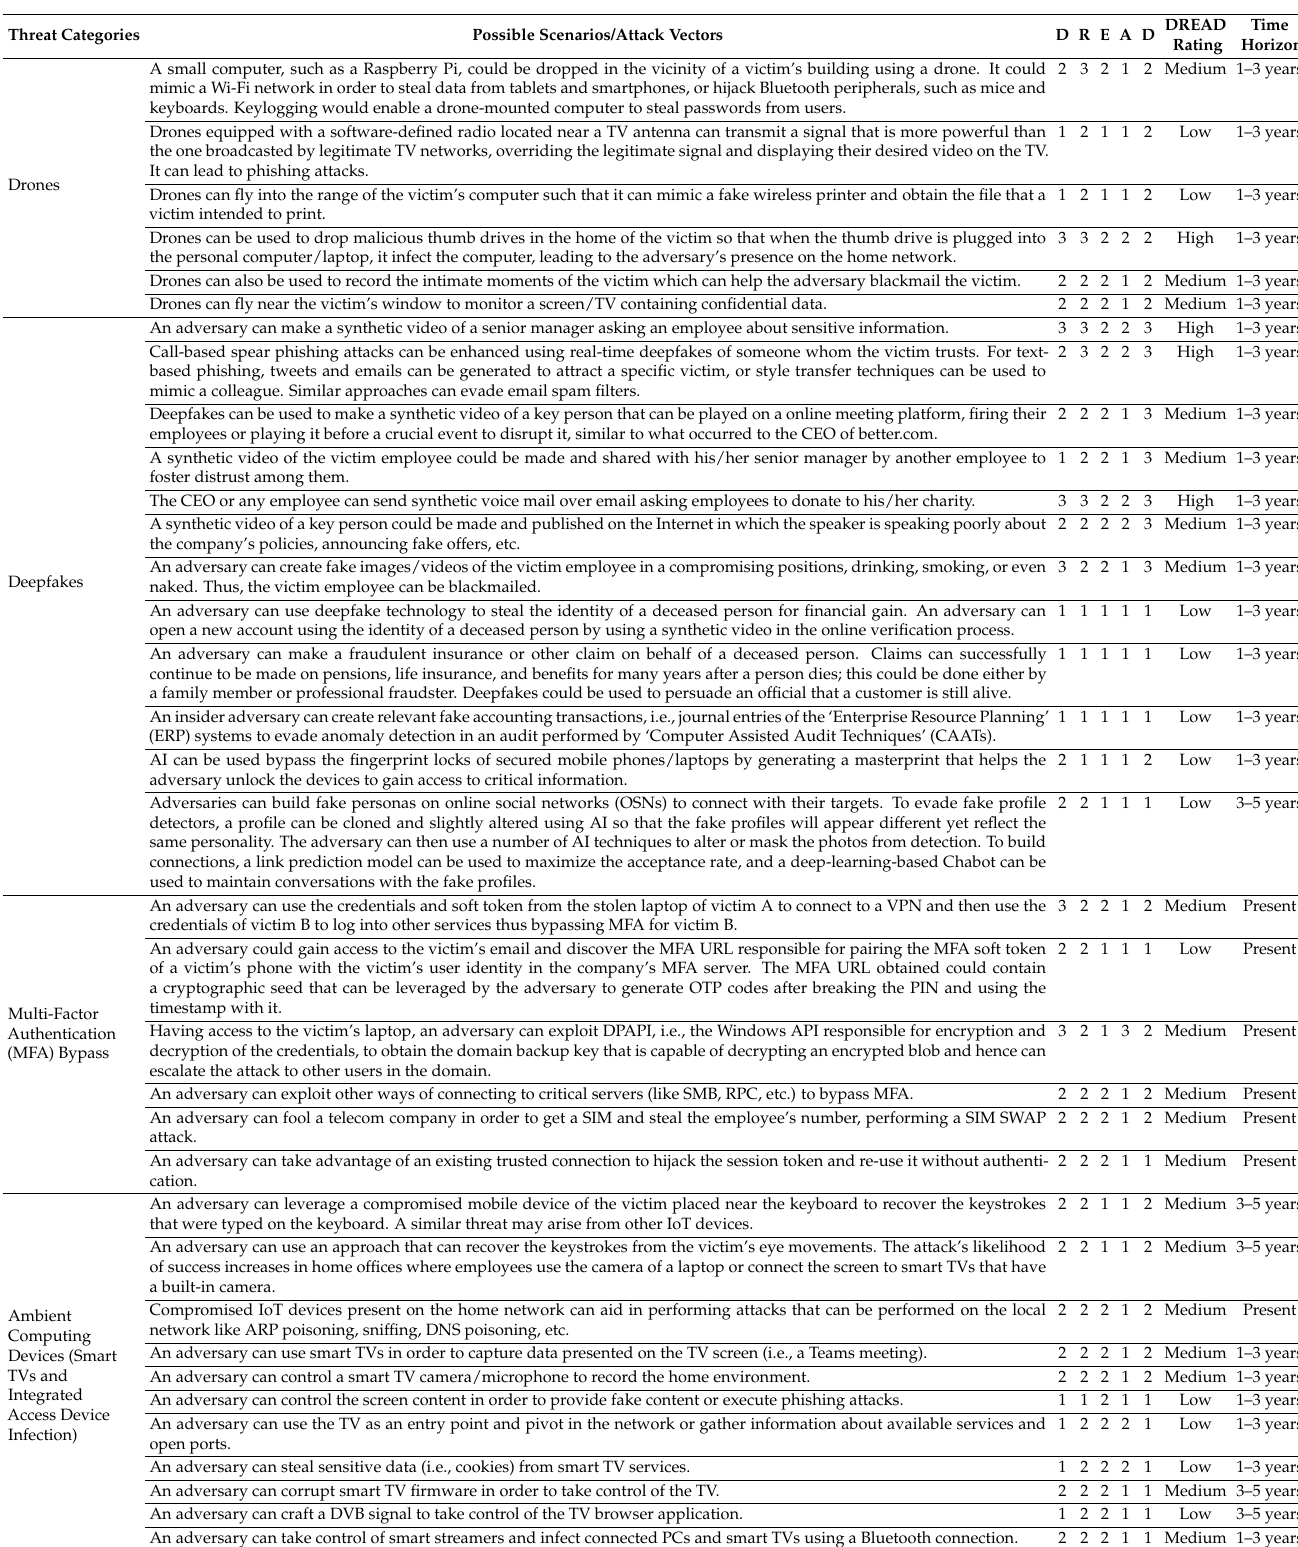
Table A1. Top threats and use